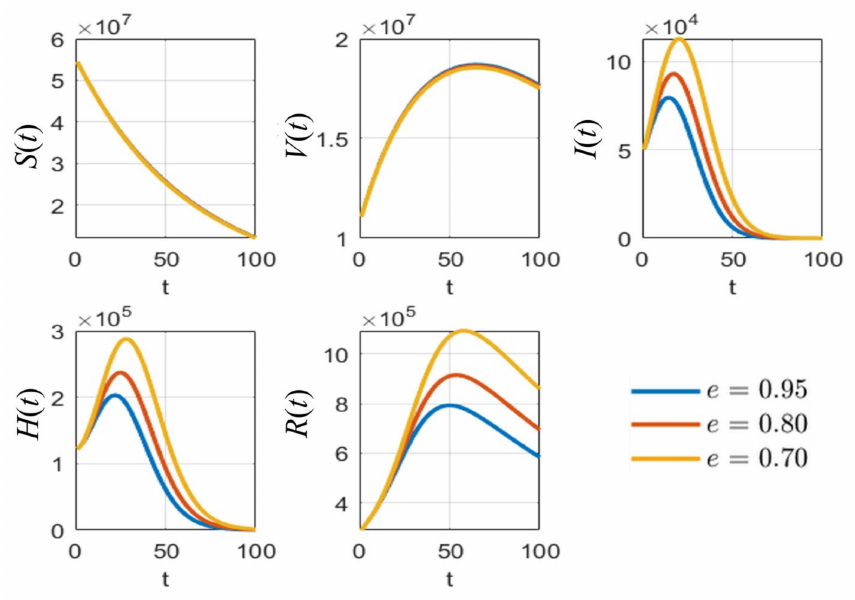
Figure 5. The simulation results of all populations compared with different values of vaccine efficacy ( e )